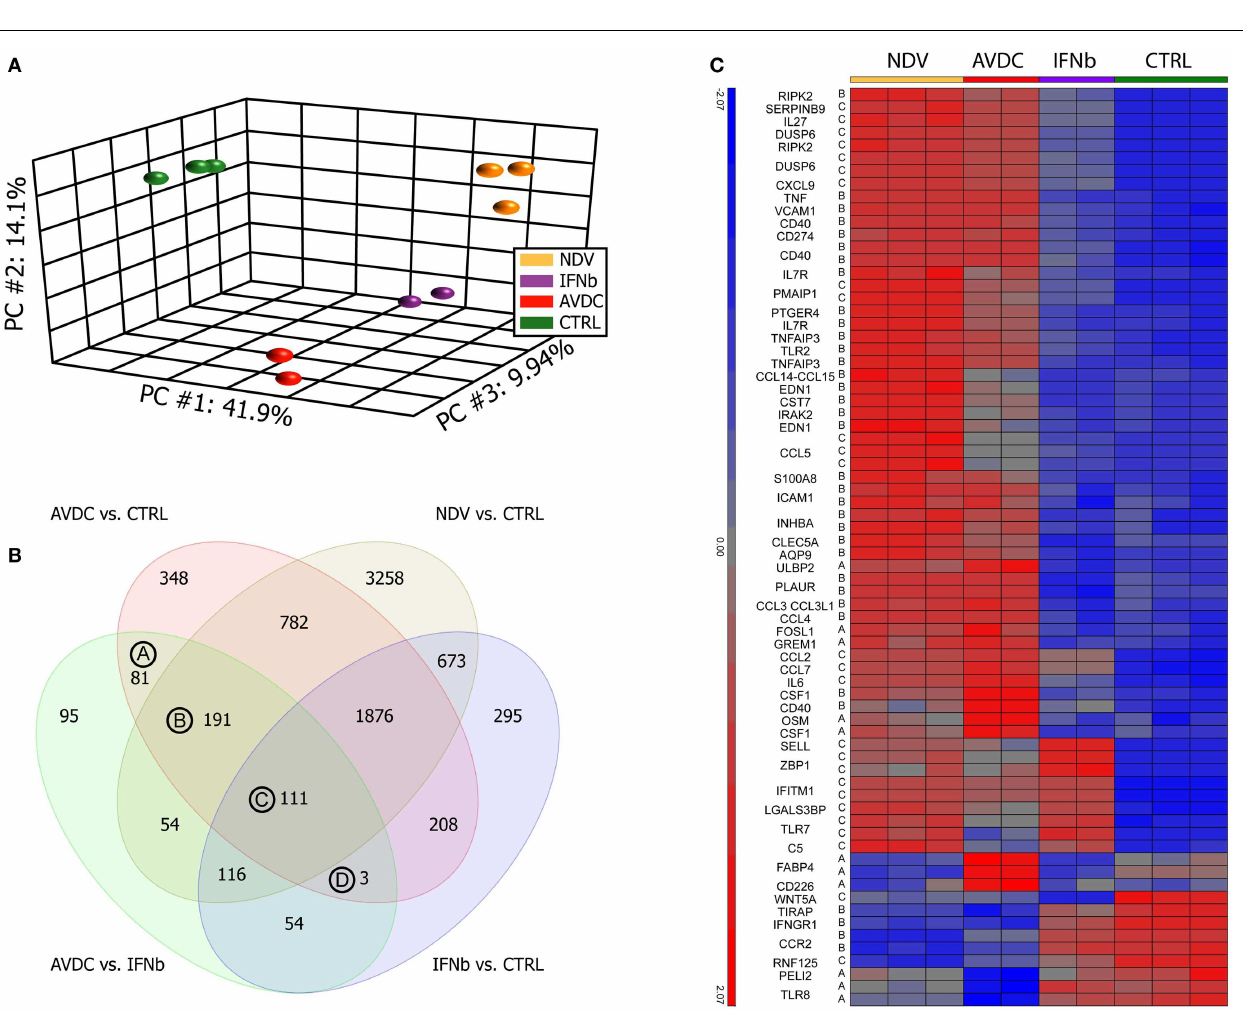
(A) Principal component analysis of samples on all genes represented on the microarray. First three principal components showing 41.9% (PC1), 14.1% (PC2), and 9.94% (PC3) of the overall change in gene expression in the data set. (B) Venn diagram comparing genes which differed (twofold, FDR p < 0.05) between each pair of conditions. (C) Genes which are differed between AVDC vs. CTRL and AVDC vs. IFN β and have a gene ontology association with anti-viral immune